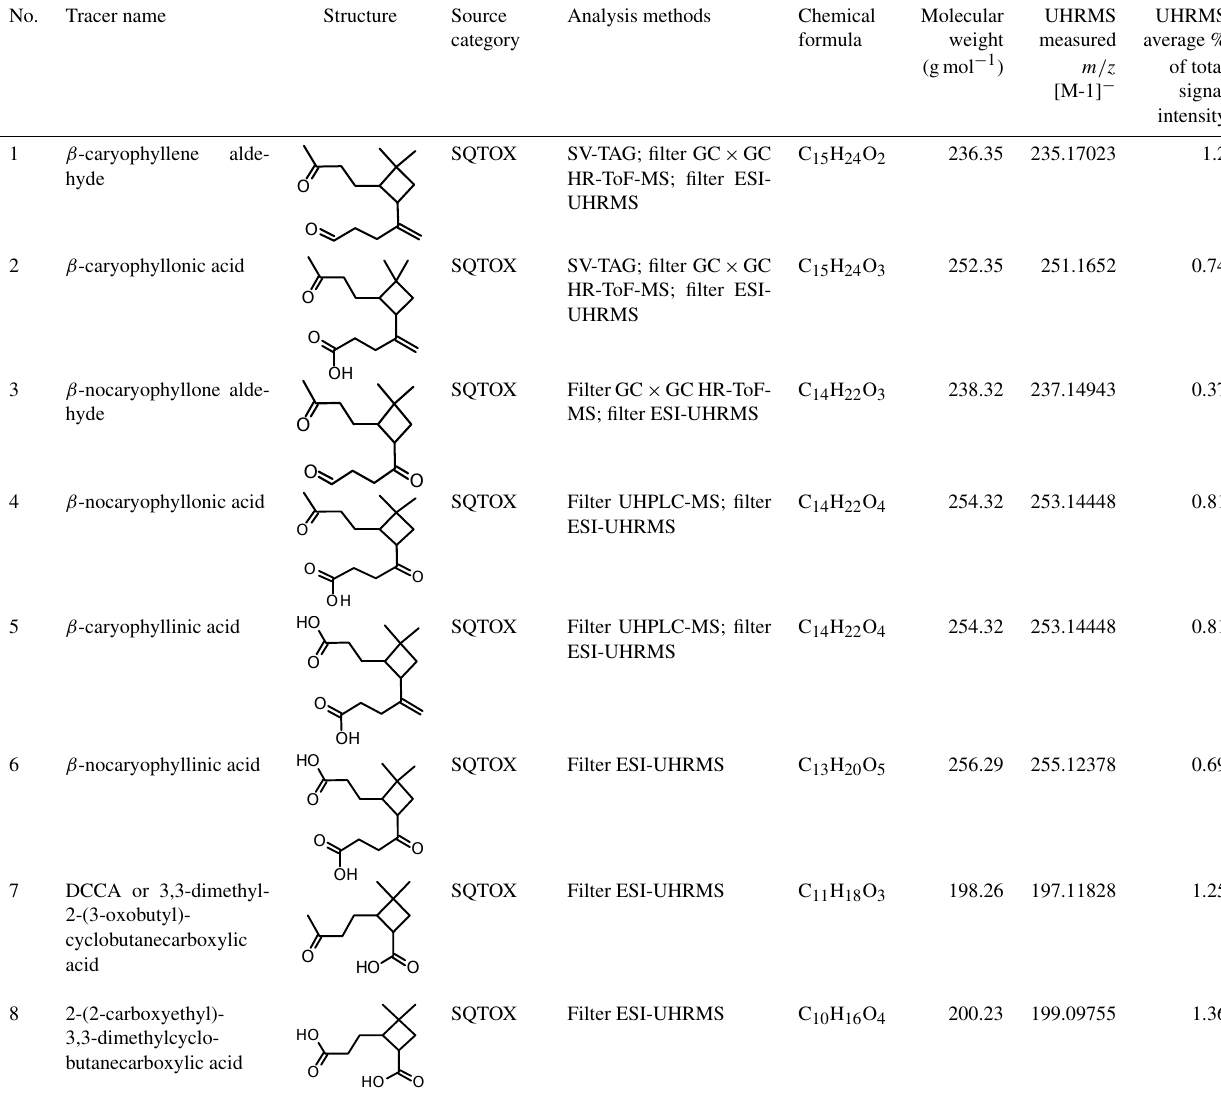
Table 2. Oxidation products from β -caryophyllene observed in central Amazonia in gas and/or particle phases listed by analysis method. These products are attributed to oxidation from the sesquiterpene (SQTOX) source category. Synthesized standards for tracers 1–6 were used to confirm identification and for